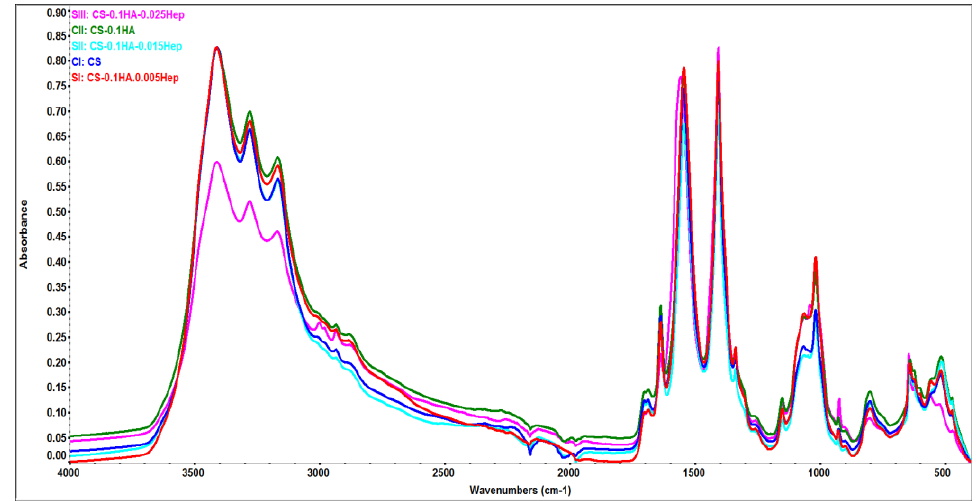
Figure 10. Surface chemical analyses of all hydrogel samples by FTIR-ATR spectroscopy. Data has been baseline corrected in OMNIC TM software.